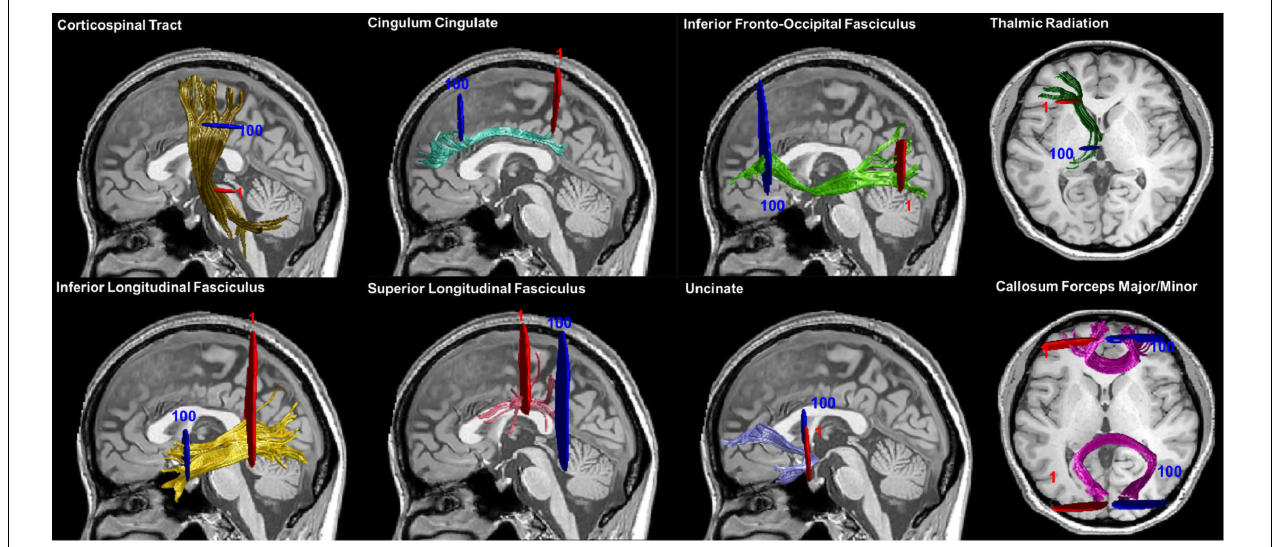
FIGURE 1 | Fiber tracts identification results. Sixteen main fiber tracts were successfully identified by AFQ. Starting and ending waypoint ROIs are described in red and blue, respectively. Abbreviation: ROIs, regions of